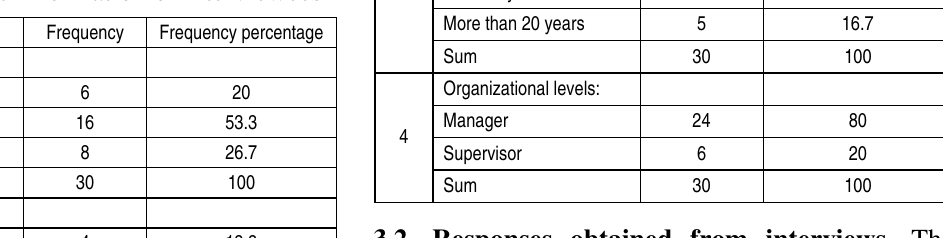
Table 1 (cont.). Basic information of interviewees